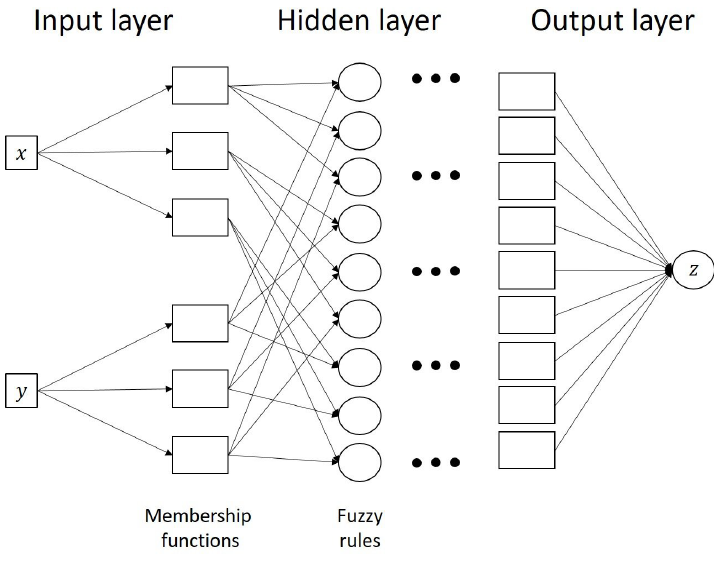
Figure 2. Adaptive Neuro-Fuzzy Inference System (ANFIS) structure with two inputs and three membership functions for each one.